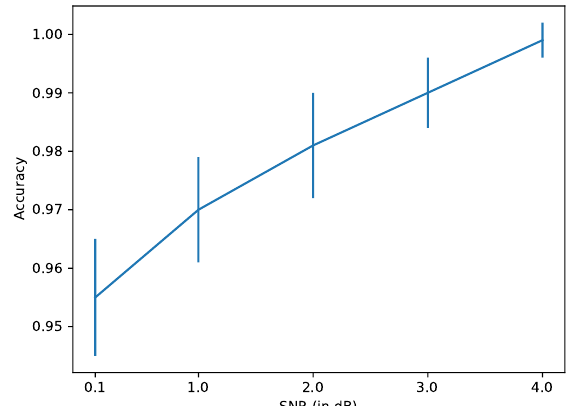
Figure 16. Neural network using MIMs monitoring five natural modes over a 10-day period. Accuracy of damage detection using noisy data with different SNR